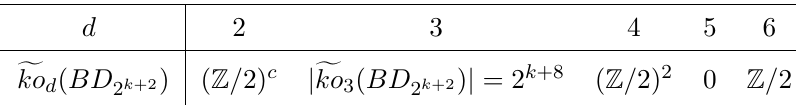
Table 9. The reduced ko -homology of BD